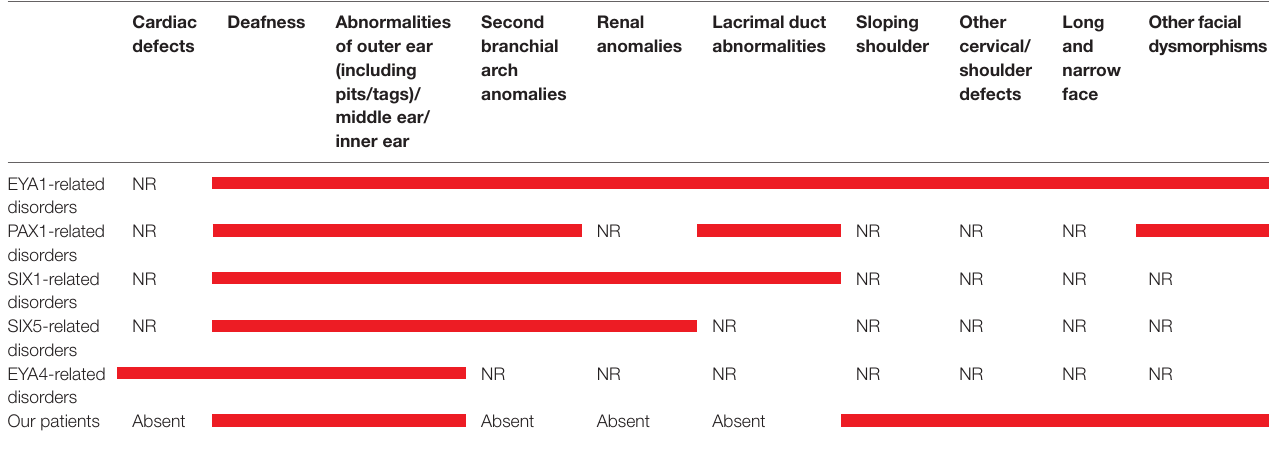
TABLE 1 | Main clinical features in our patient and in those with mutations in EYA1, PAX1, SIX1, SIX5, and EYA4. Red bars indicate the presence of the clinical signs. NR means “not reported”. Cardiac